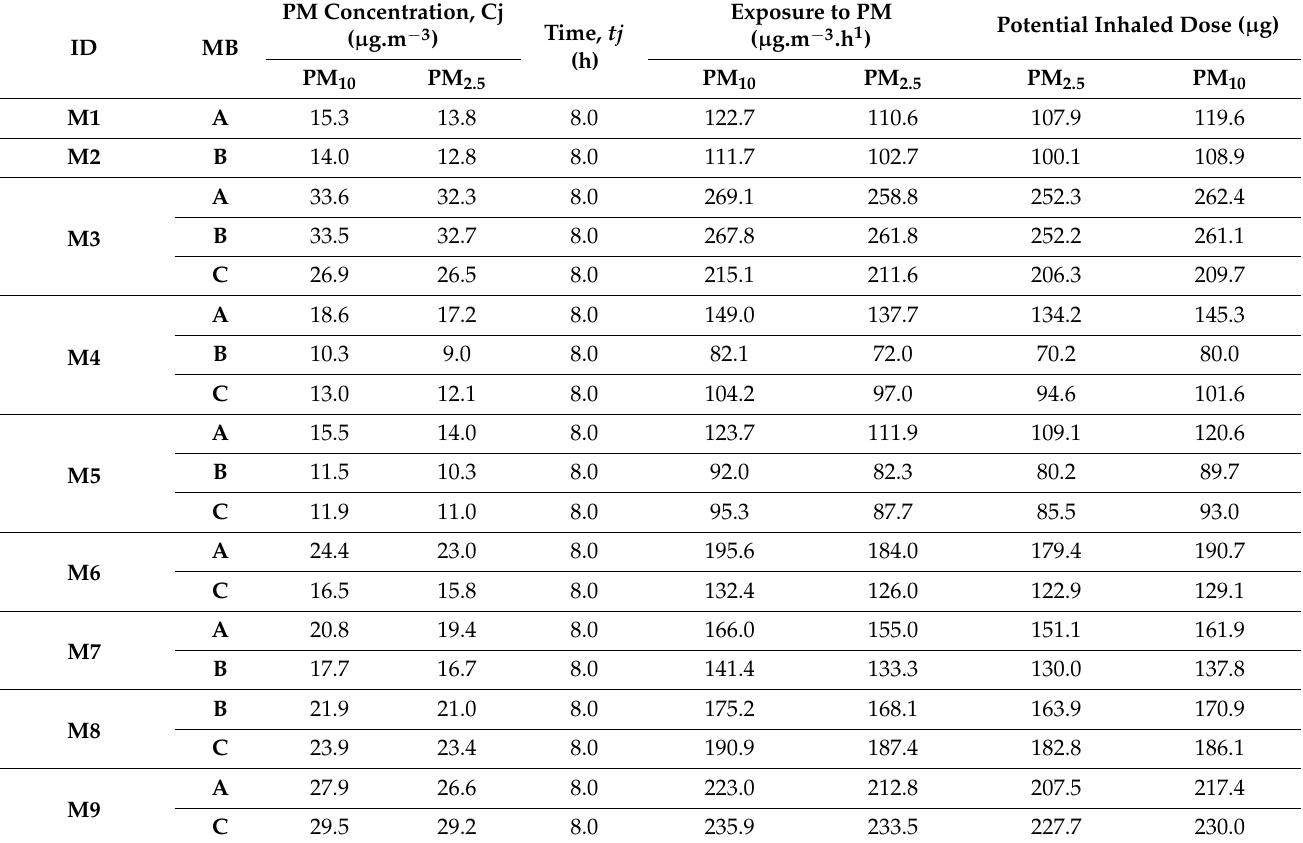
Table 2. PM 10 and PM 2.5 exposure and correspondent potential inhaled dose during the working period at the studied